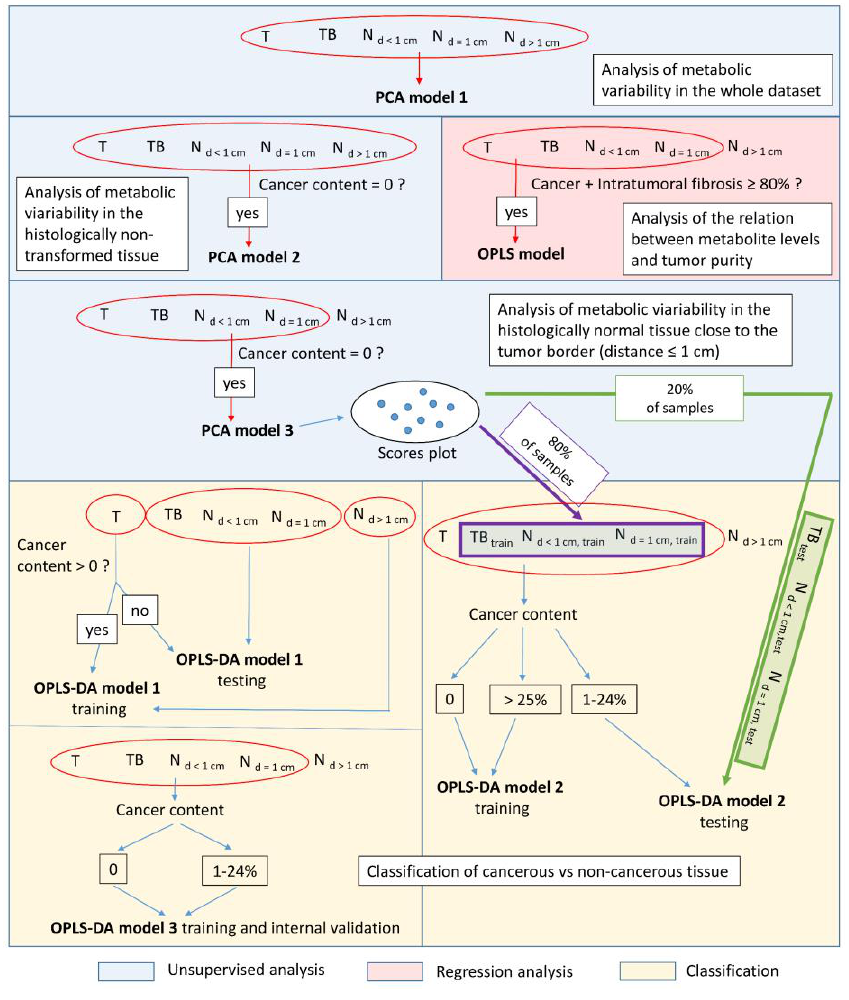
Figure 1. Multivariate analysis scheme.